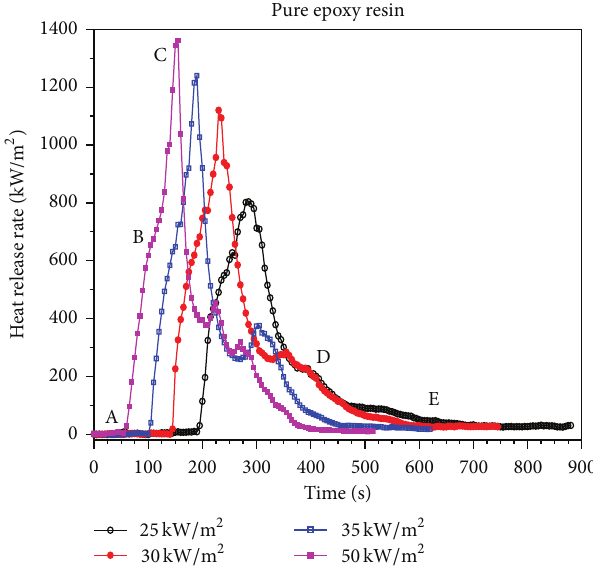
Figure 2: HRR profile of neat epoxy subjected to different external heat fluxes.